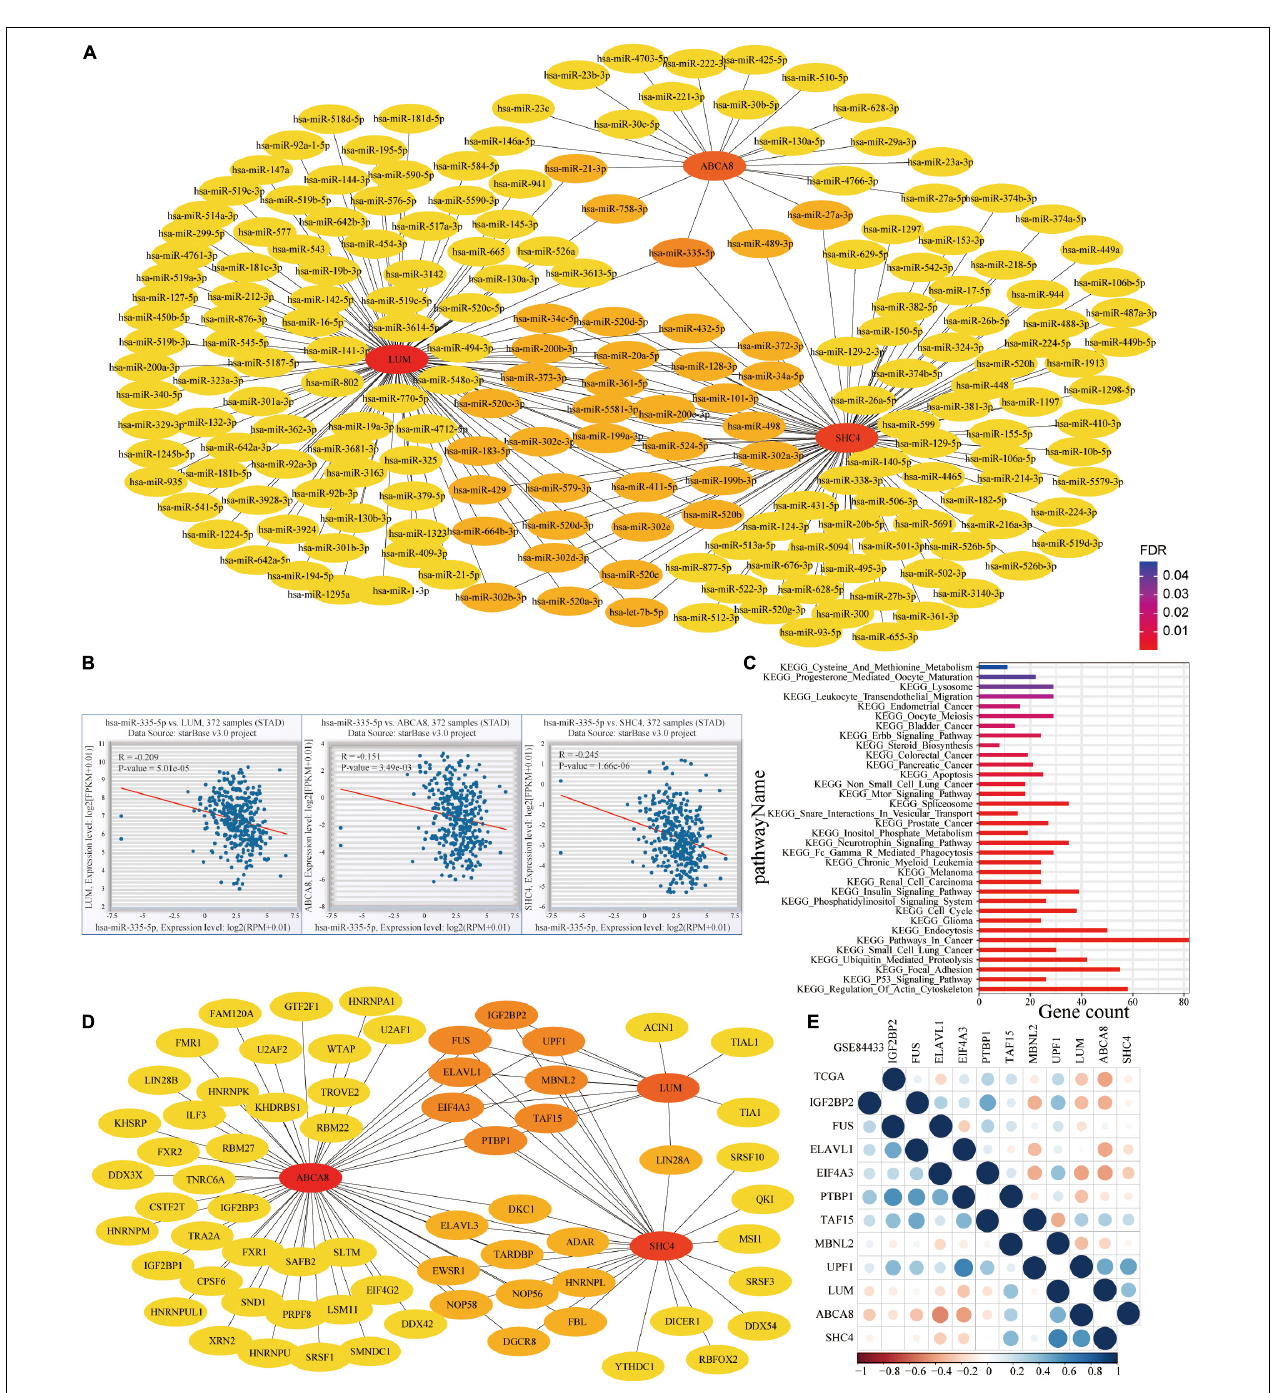
FIGURE 13 | MicroRNA (miRNA) and RNA binding proteins (RBPs) networks of 3 key genes. (A) MiRNAs of LUM, ABCA8 and SHC4. (B) Hsa-miR-335-5p, shared by 3 key genes, was significantly and negatively related to them. (C) KEGG enrichment results for the target genes of hsa-miR-335-5p. (D) RBPs of 3 key genes. (E) Spearman correlation between 3 key genes and 8 shared RBPs in the TCGA and